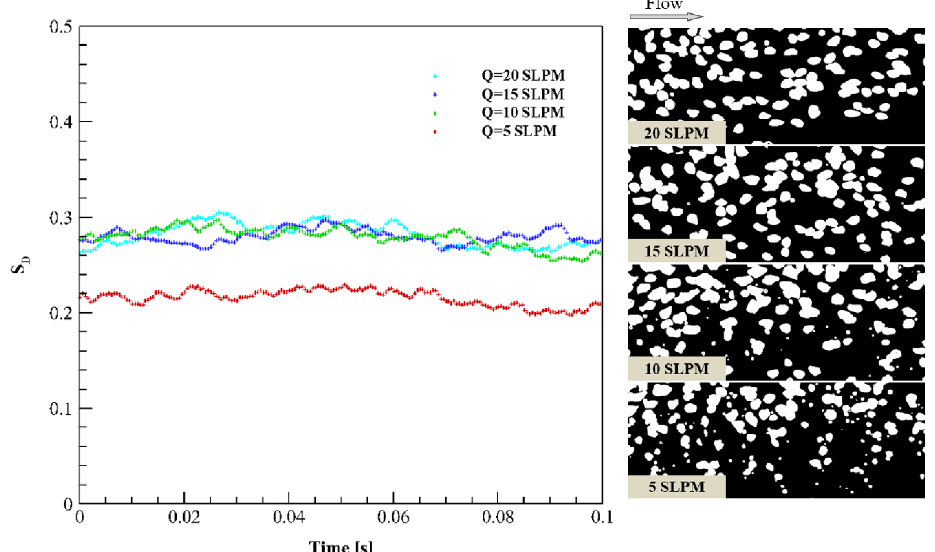
Figure 11. Change of spatial density with time at the free-stream velocity of 3 m/s for various air injection rates. The arrow indicates the direction of the free-stream velocity